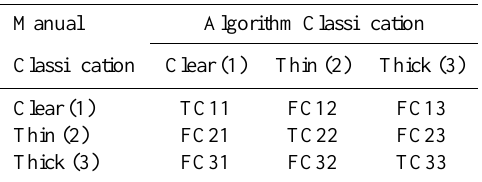
Table 1. Confusion matrix for CDOC. For example, true class 11 (TC11) denotes the percentage of clear pixels that were correctly classified as clear pixels, false class 12 (FC12) denotes the percent- age of clear pixels that were classified as thin cloud pixels, false class 13 (FC13) denotes the percentage of clear pixels that were classified as thick cloud pixels, false class 21 (FC21) denotes the percentage of thin cloud pixels that were classified as clear pixels, and so on.